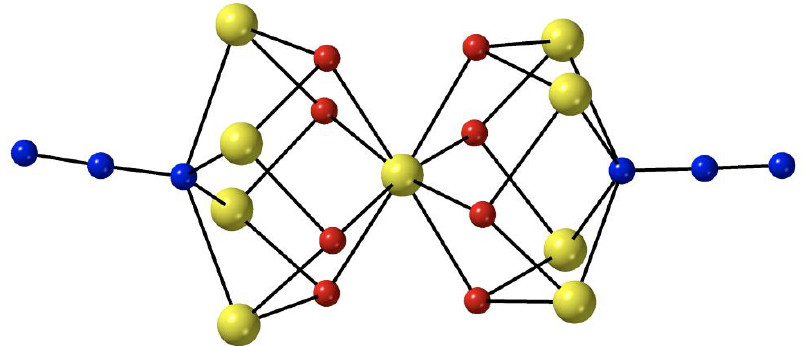
Figure 5. The {Fe II 9 (4.40-N 3 ) 2 ( µ 3 -OR) 8 } 8 + core of cluster 6 . The Fe II centers are shown in dark yellow, the nitrogen atoms in blue and the oxygen atoms are shown in red. Modified from reference